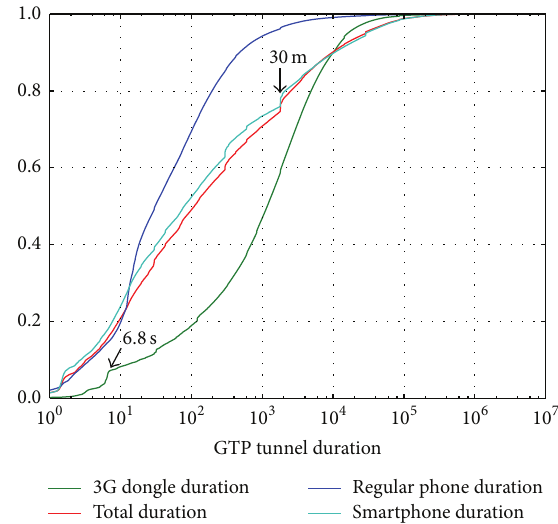
Figure 4: Tunnel duration distribution, separated for 3G dongles, smartphones, and regular phones.